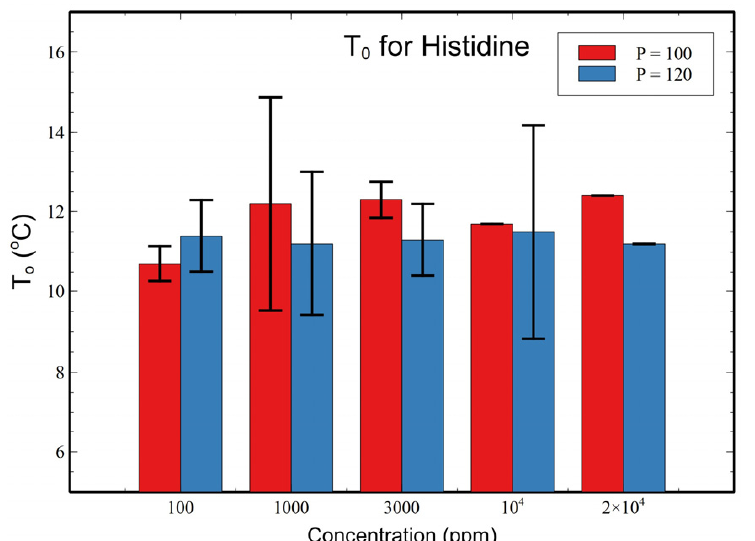
Figure 3. Initial nucleation temperature (T 0 ) reported for histidine (from constant ramping experiments) at two different initial pressures (100 bar, 120 bar). Margin of error was calculated for 90% confidence interval using t distribution. No margin of error was available for cases with no standard